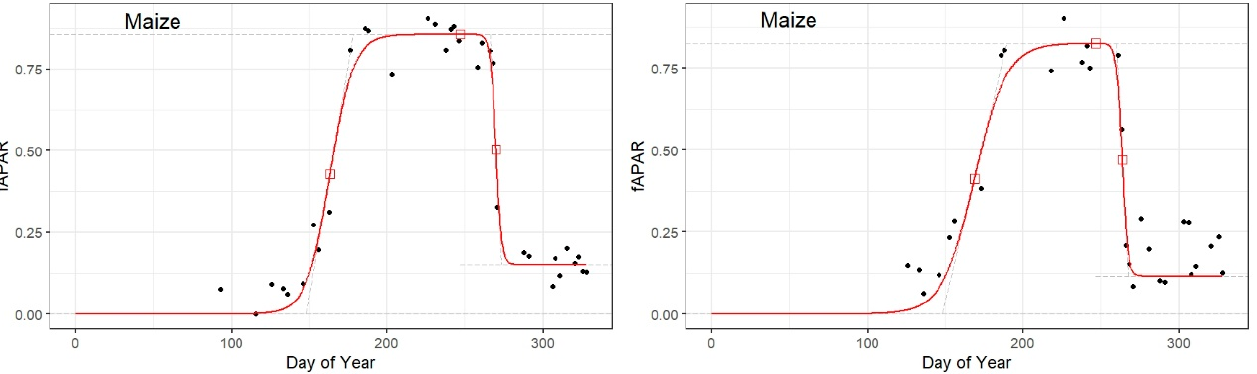
Figure 12. Relationship between Sentinel-2-, DMC-, and DHP-derived fCover during three years of measurement in arable fields. Each dot represents the median value for a field. The straight line represents the 1:1 line.